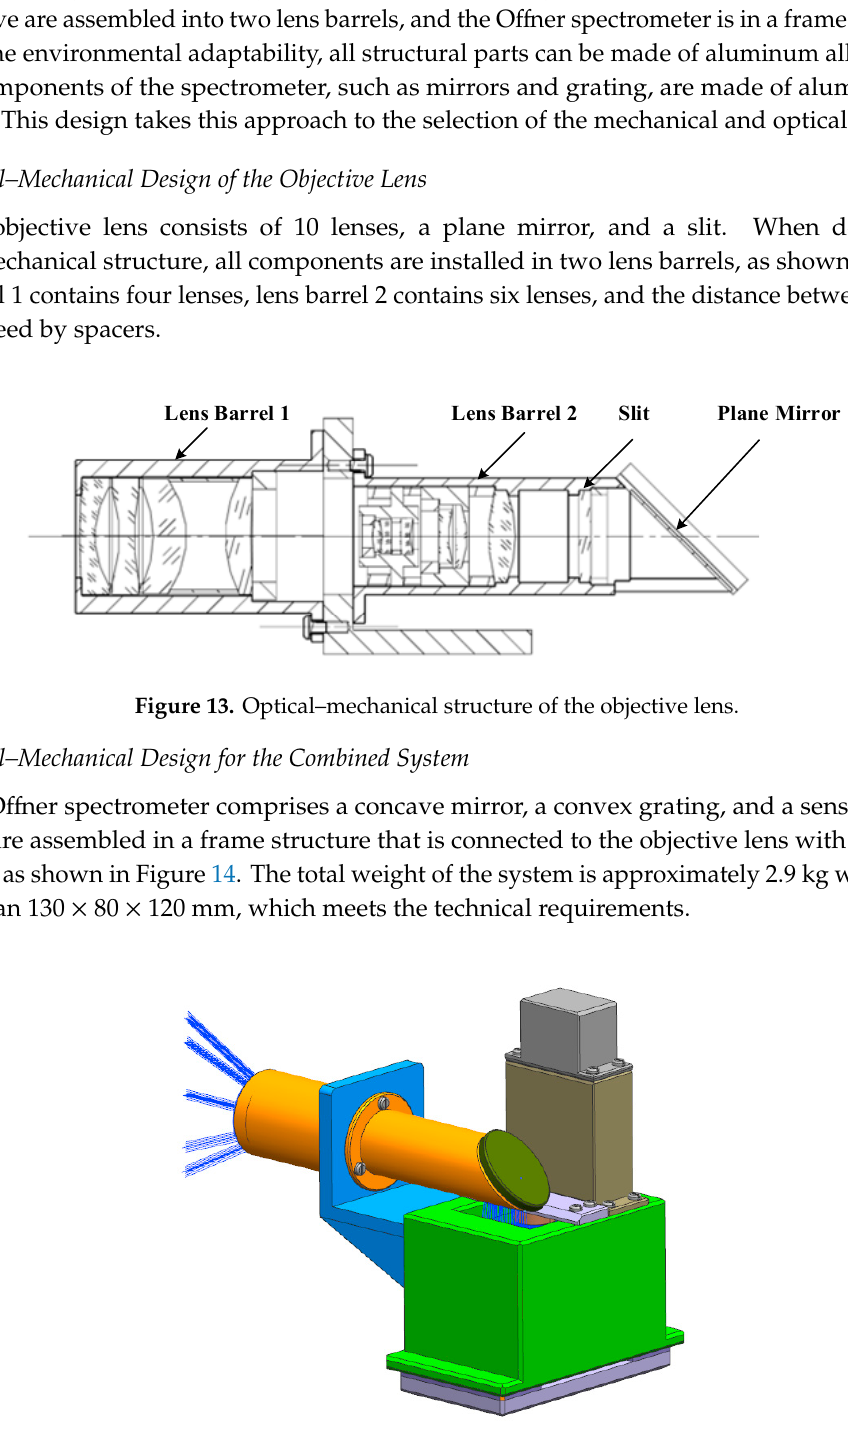
Figure 12. MTF of the integrated system ( a ) 400 nm; ( b ) 600 nm; ( c ) 800 nm; ( d ) 1000 nm.